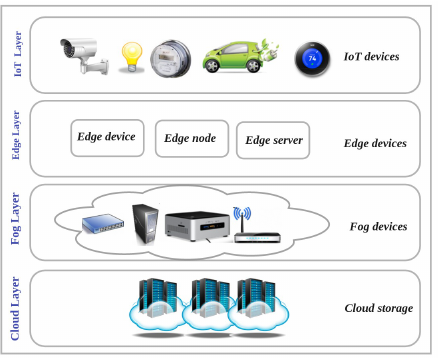
Figure 7. The basic model of cloud, fog, and edge